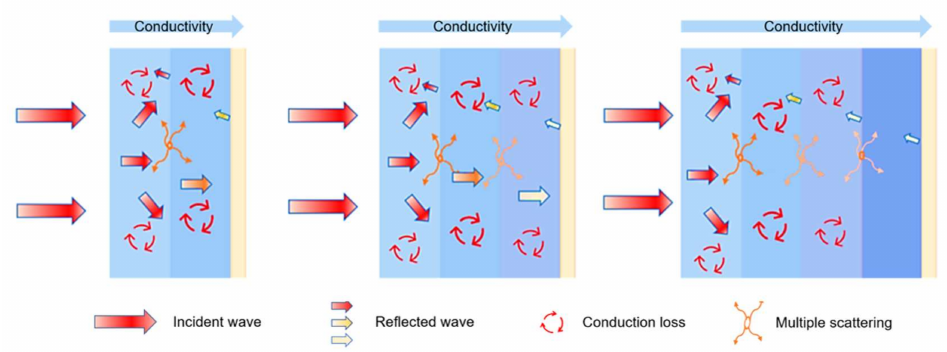
Figure 9. The wave-absorption mechanism of the multi-layer HC composites.